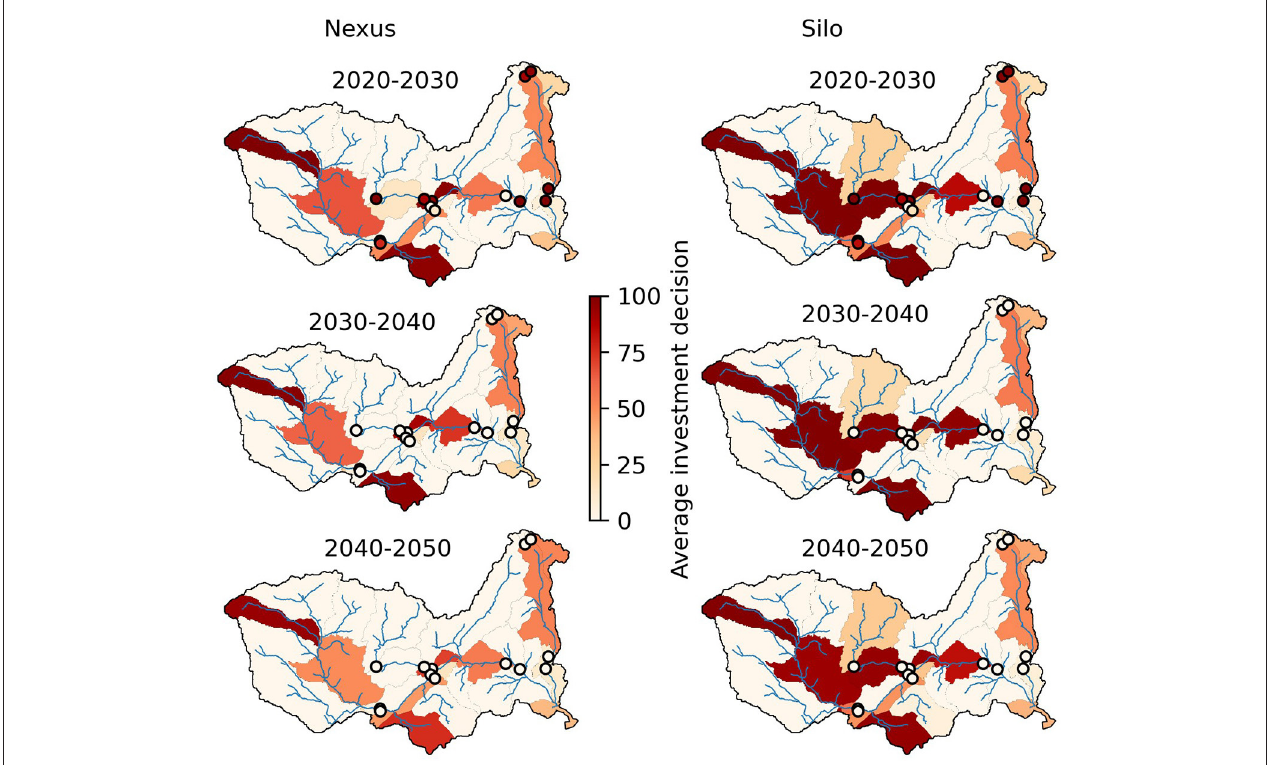
FIGURE 8 | Investments in irrigation and hydropower for the nexus and silo frameworks. Dots represent hydropower plants, catchments represent irrigation. The average investment decisions represent the percentage of scenarios where hydropower investments are found beneficial (NPV > 0), and the average invested percentage in irrigation expansion for irrigation investments as described in World Bank (2010).